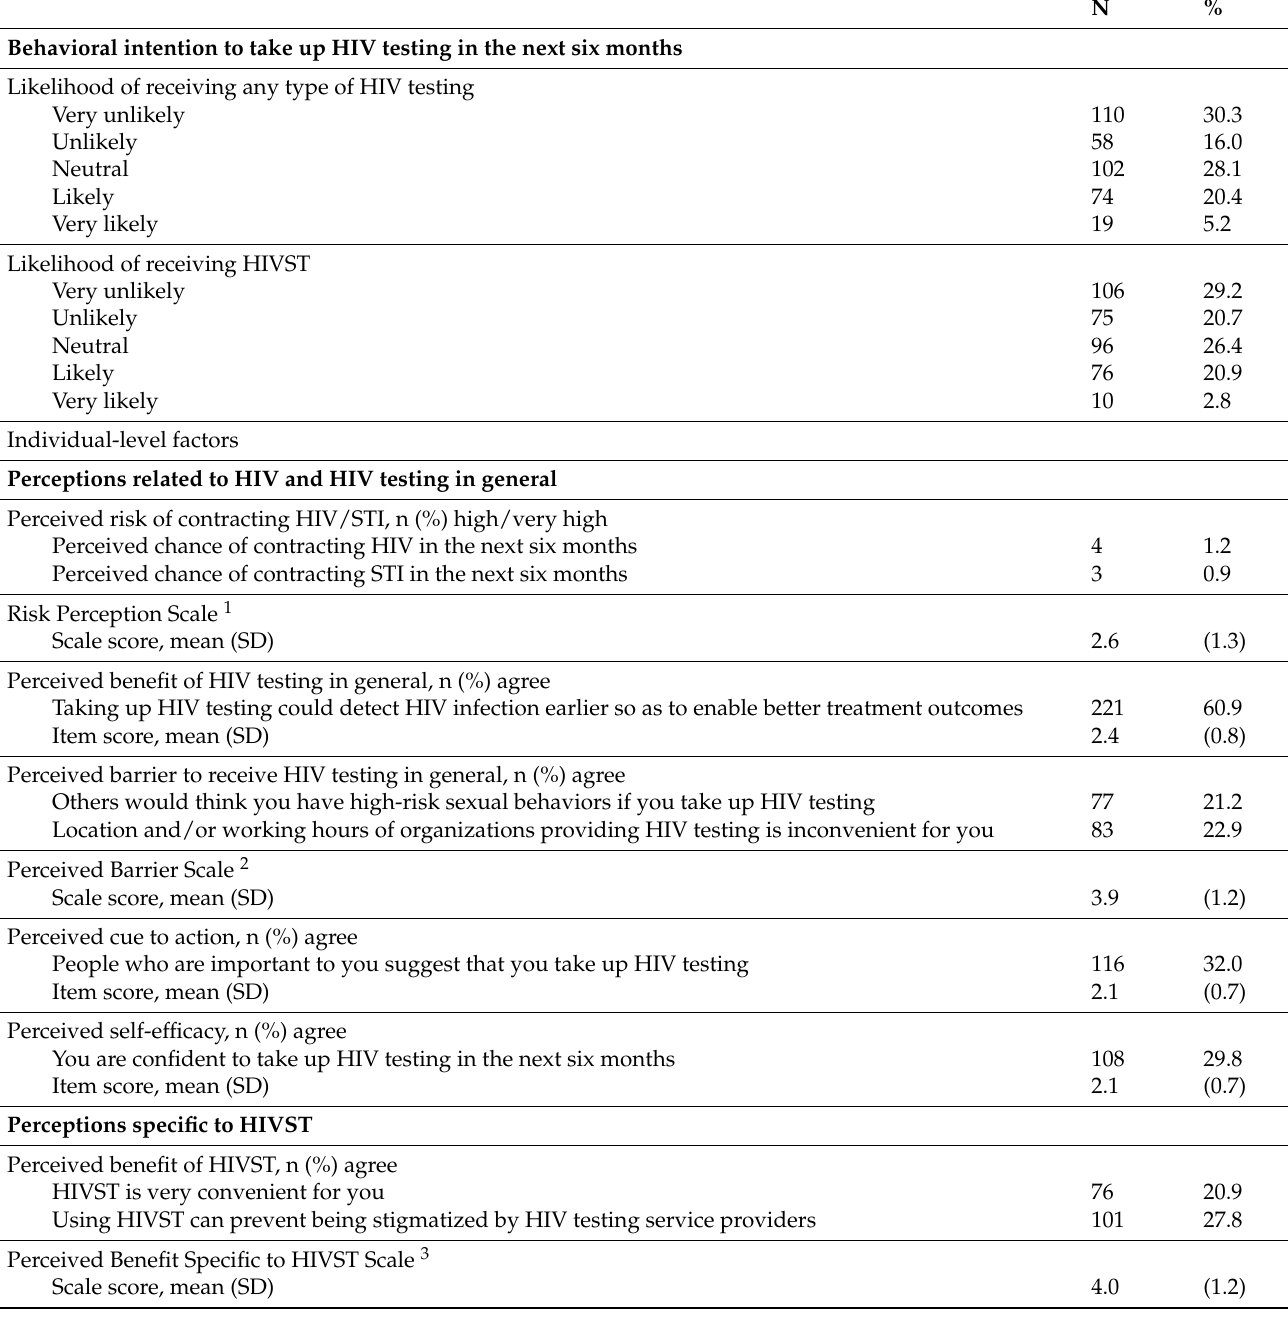
Table 2. Behavioral intention to use any type of HIV testing and HIVST, and descriptive data of variables at the individual and interpersonal levels (n = 363).